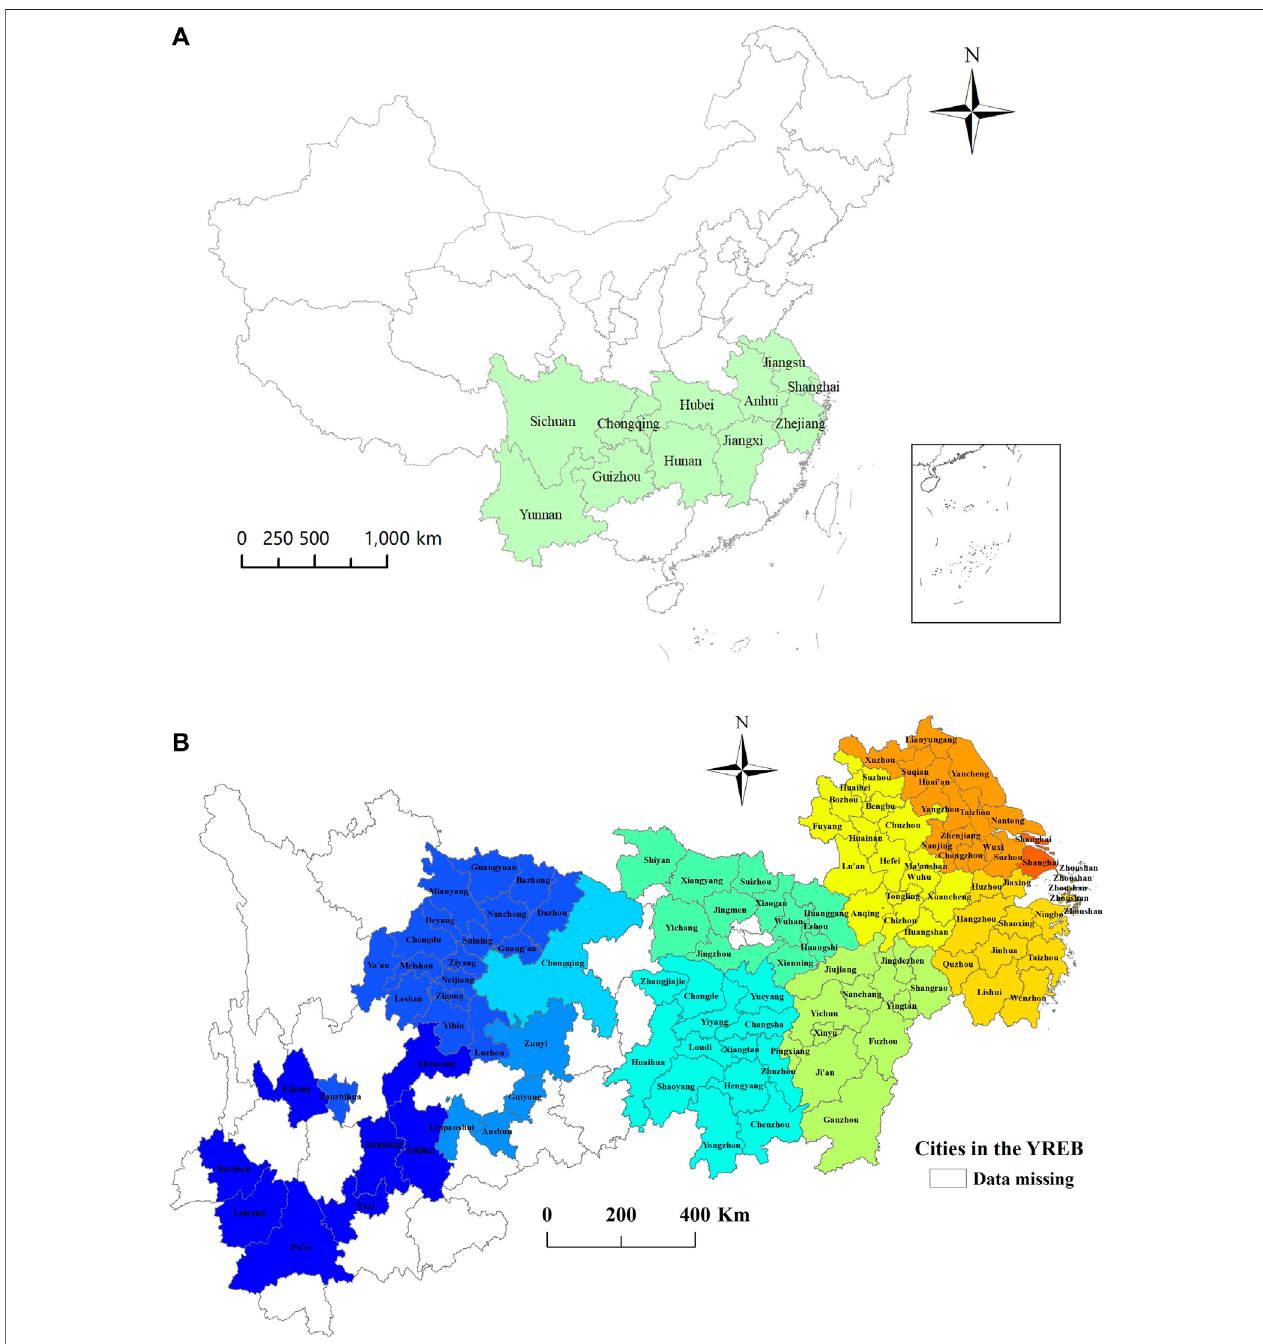
FIGURE 1 | (A) represents the schematic of the locations of the 11 surveyed provinces — Shanghai, Jiangsu, Zhejiang, Anhui, Jiangxi, Hubei, Hunan, Chongqing, Guizhou, Sichuan, and Yunnan in the Yangtze River Economic Belt, China. (B) shows the 108 cities, including two municipalities, fi ve sub-provincial cities, and 101 prefecture-level